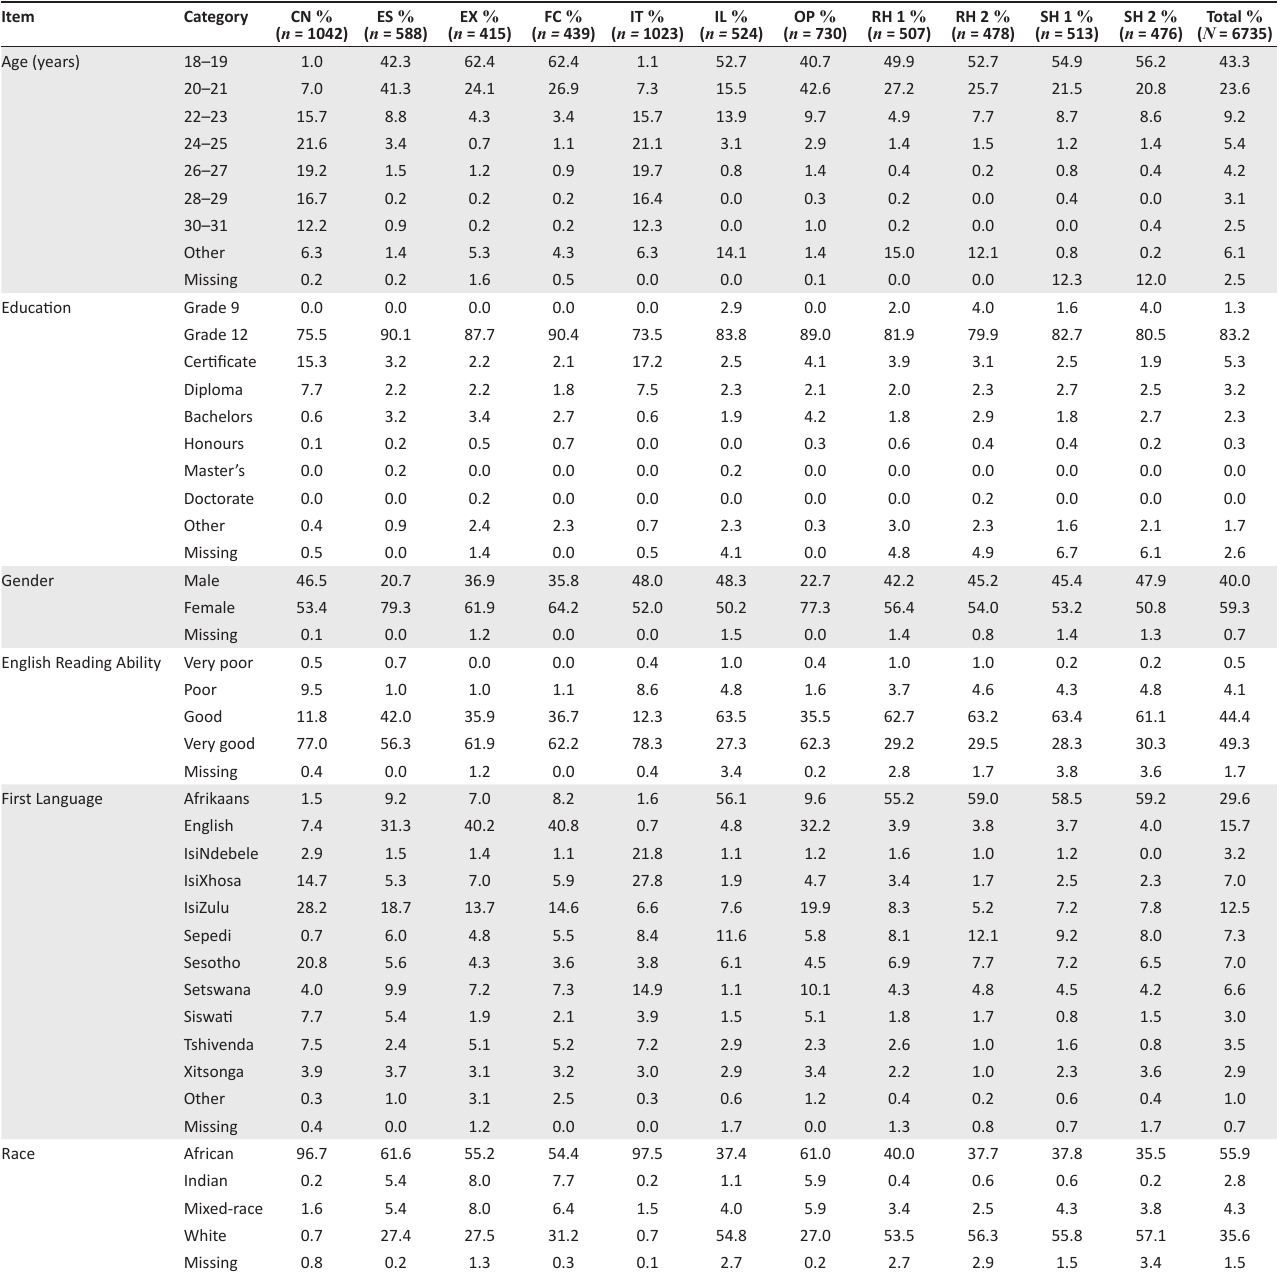
TABLE 3: Characteristics of the participants ( N = 6735).